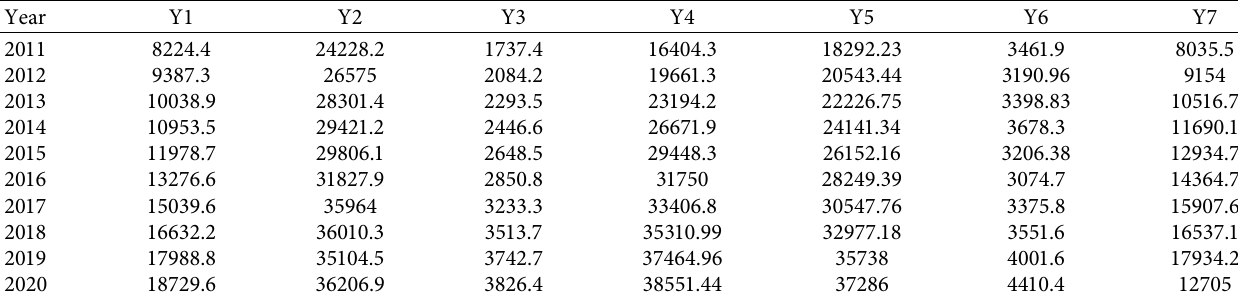
Table 6: Original data on economic indices.